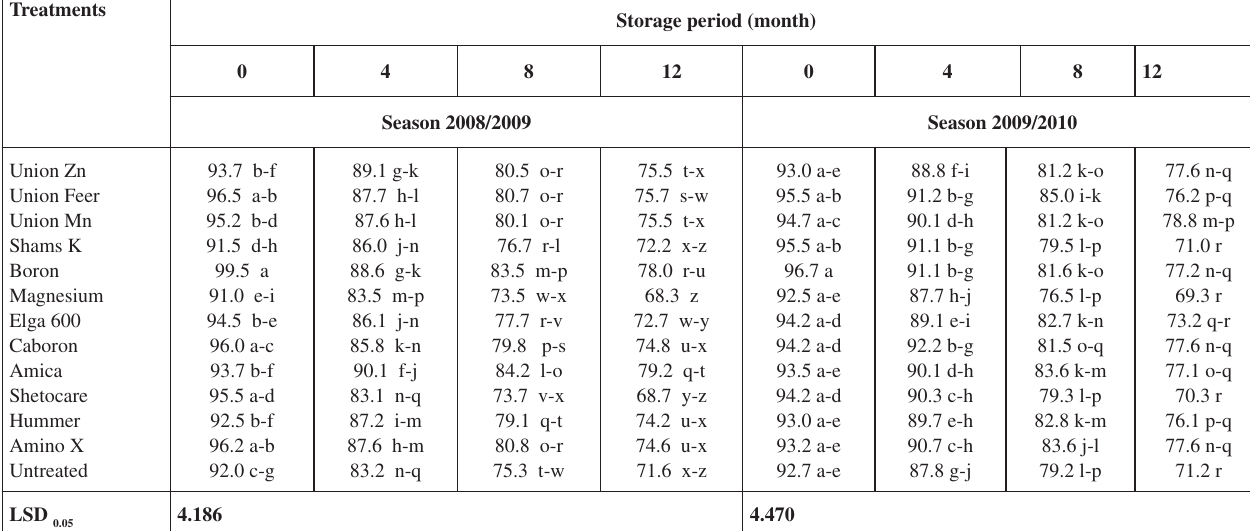
and 2009/2010 seasons